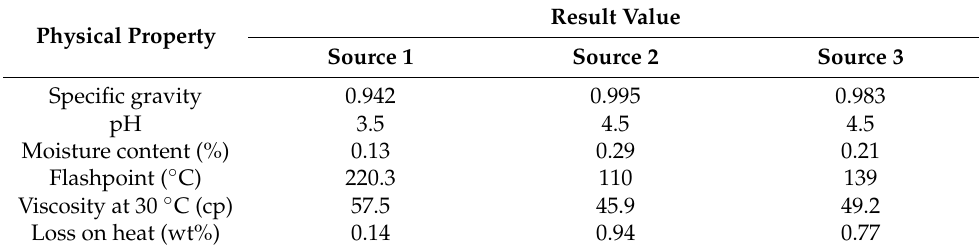
Table 2. Physical properties for various resources of